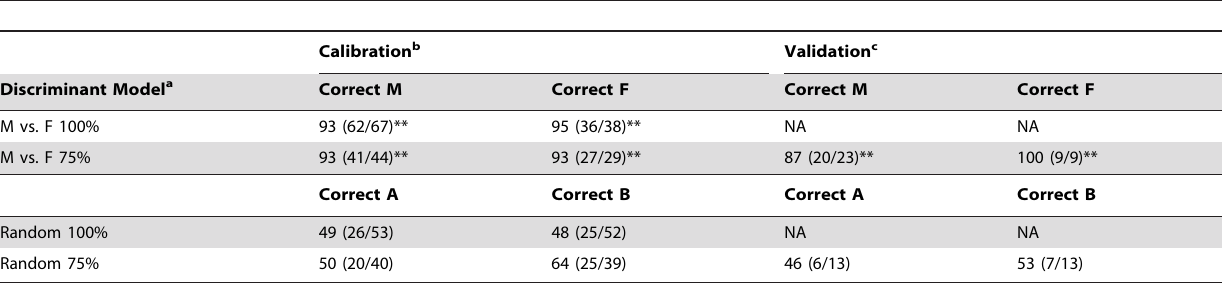
Table 7. The effect of using fecal samples derived from ‘‘leaf only’’ bamboo diets on the ability of near infrared spectroscopy to discriminate between adult male and female captive giant pandas ( Ailuropoda melanoleuca